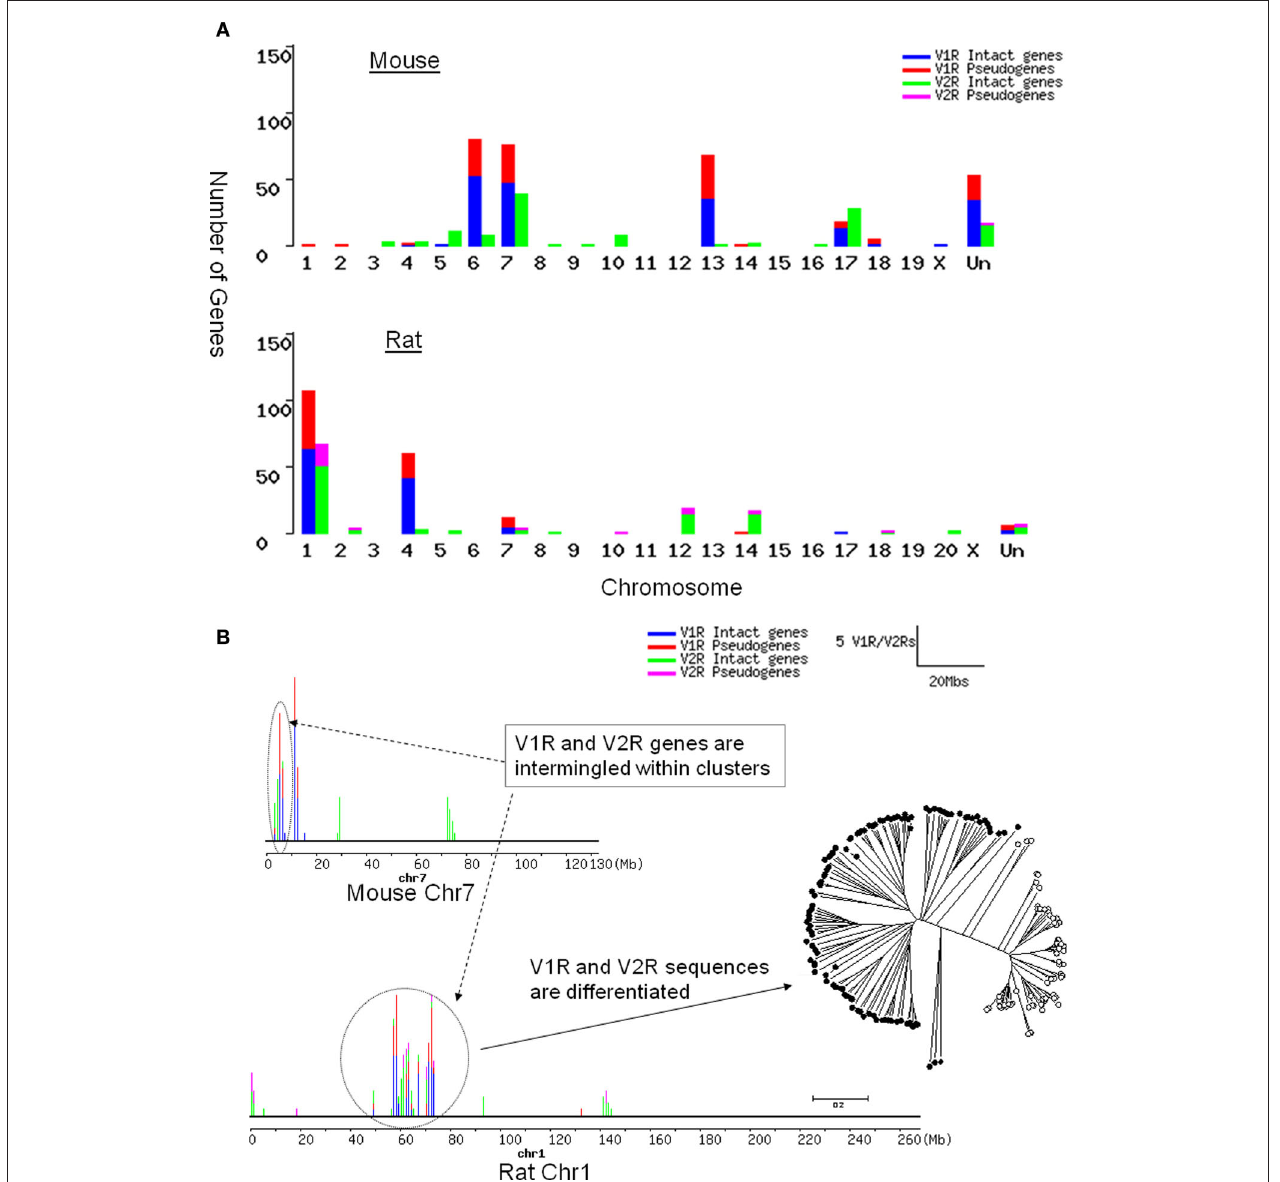
The height of each bar is proportional to the number of genes in that locus. Rat chromosome 1 and mouse chromosome 7 are drawn according to the rn3 and mm5 assembly respectively. The number of V1R/V2R genes per 1 Mb is shown as bars on each chromosome. The ellipse and circle in dotted line are drawn to point out the cluster with intermingled V1Rs and V2Rs. Phylogenetic tree with VRs in the circled cluster on rat chromosome 1 was drawn to illustrate that their sequences are still differentiated clearly as V1R or V2Rs, even though their genomic locations are